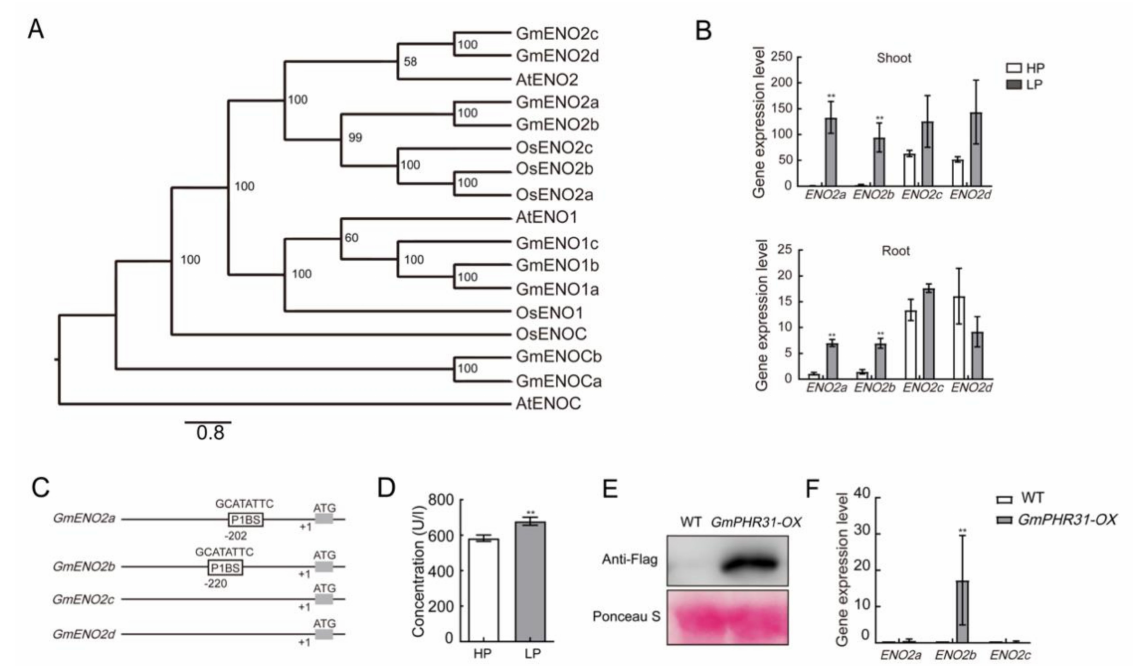
Figure 5. Enolase was induced by phosphate starvation. ( A ) Phylogenetic analysis of the ENO proteins in Arabidopsis, rice, and soybean. At, Arabidopsis thaliana ; Os, Oryza sativa ; Gm, Glycine max . ( B ) The mRNA levels of soybean ENO2 genes in response to phosphate starvation. ( C ) Diagram showing the structure of the GmENO 2 promoters. P1BS motifs were boxed. ( D ) Enolase concentration was increased by LP treatment in soybean leaves. ( E ) Immunoblot of GmPHR31 protein level. Ponceau stain was used as loading control. ( F ) Expression level of GmENO2b increased in GmPHR31 overexpression line. Error bars: SEM. Asterisks indicate significant differences by Student t-tests: ** p